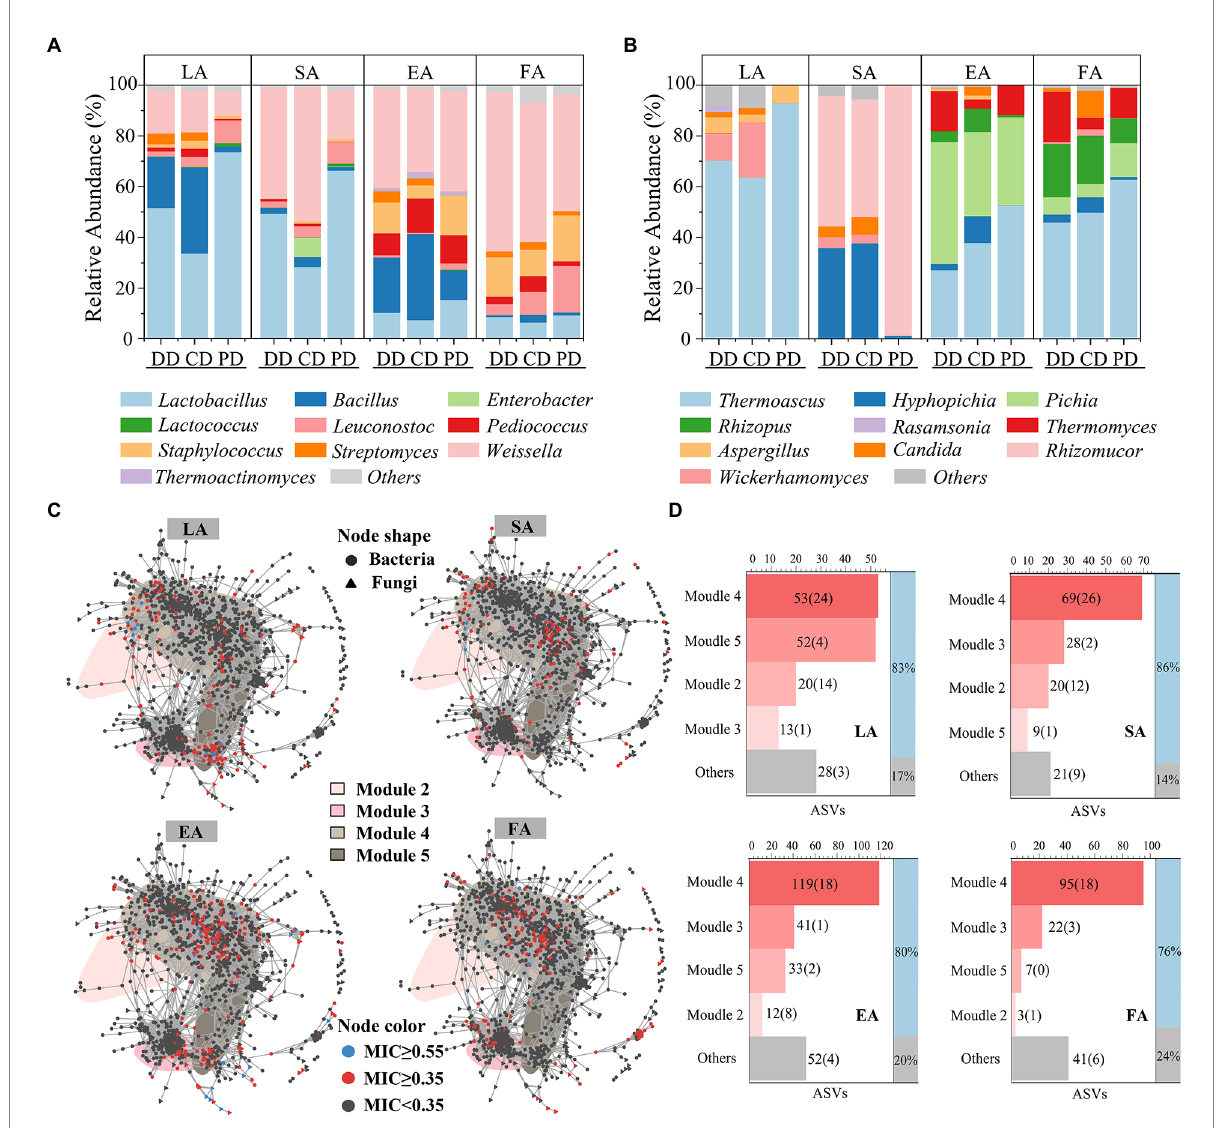
FIGURE 6 Correlation analysis Daqu microbial community with enzymatic activity. Community composition of bacterial (A) and fungal (B) that contribute significantly ( e ASVs, maximum information coefficient ≥ 0.35) to MTD enzymatic activity, expressed by the average relative abundance of all samples of each type MTD during the fermentation process. (C) Distribution of e ASVs in co-occurrence network. LA, SA, EA and FA, respectively, represent liquefying-, saccharifying-, esterifying- and fermenting-activity. (D) The number of e ASVs ( bs ASVs) in bs Module, “Others” represents the total number of e ASVs distributed in insensitive modules. The ratio of e ASVs contained in bs Module to all detected e ASVs is shown in the right